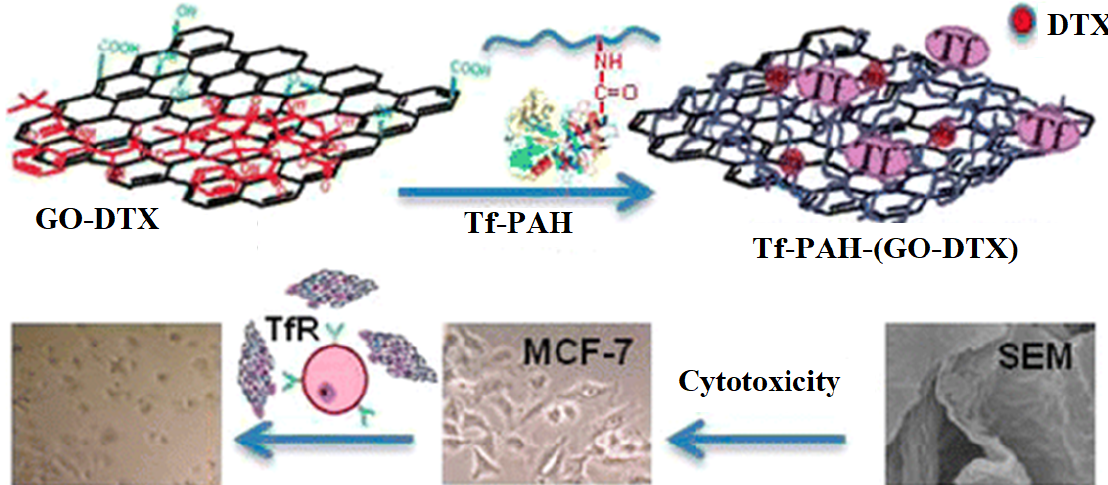
Figure 2. Transferrin-poly (allamine hydrochloride) (Tf-PAH) modified Graphene Oxide (GO) for docetaxel (DTX) delivery. [50,51] Reprinted with permission from Elsevier.